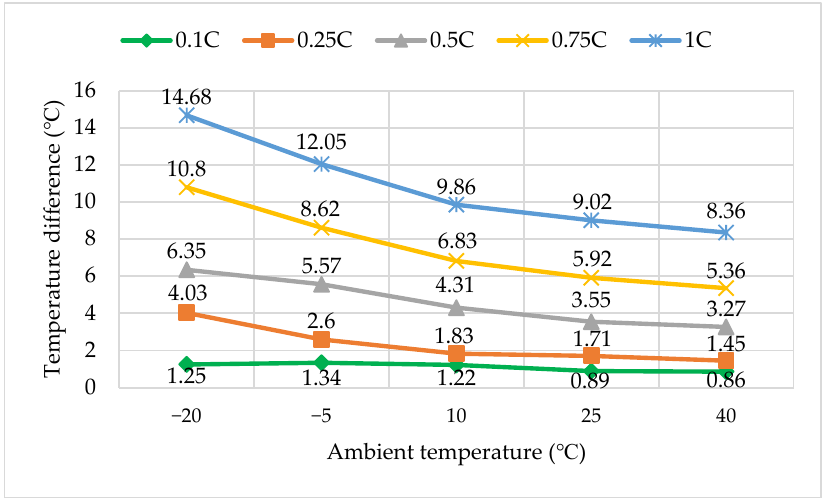
Figure 17. Comparison of the maximum temperature difference on the surface of the battery during discharge.